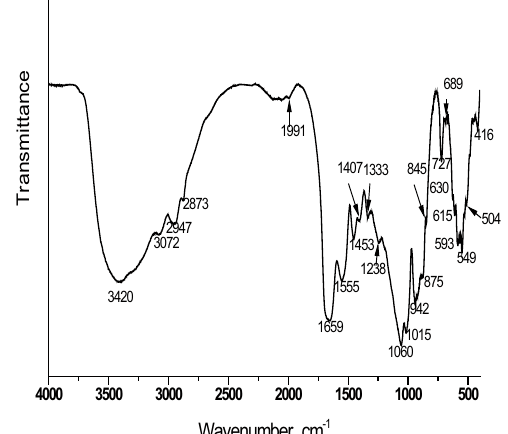
Figure 4. FTIR of G/S hybrid (75:25 wt.%) before immersion in 1.5